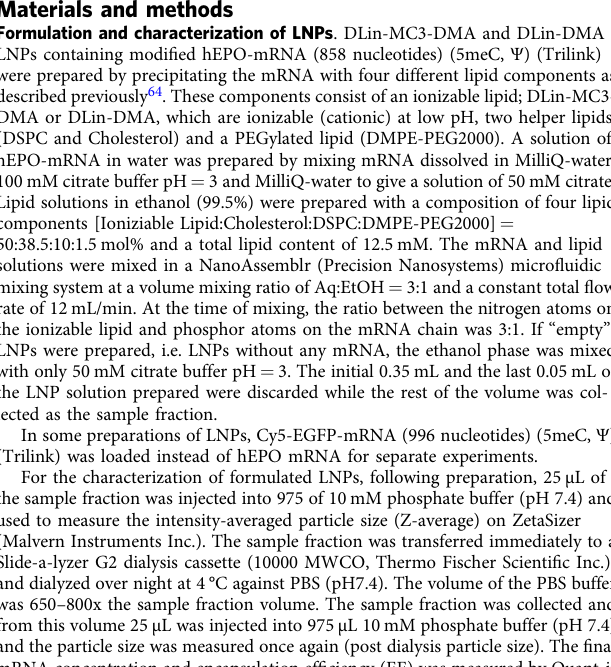
that part of the mRNA delivery is achieved by